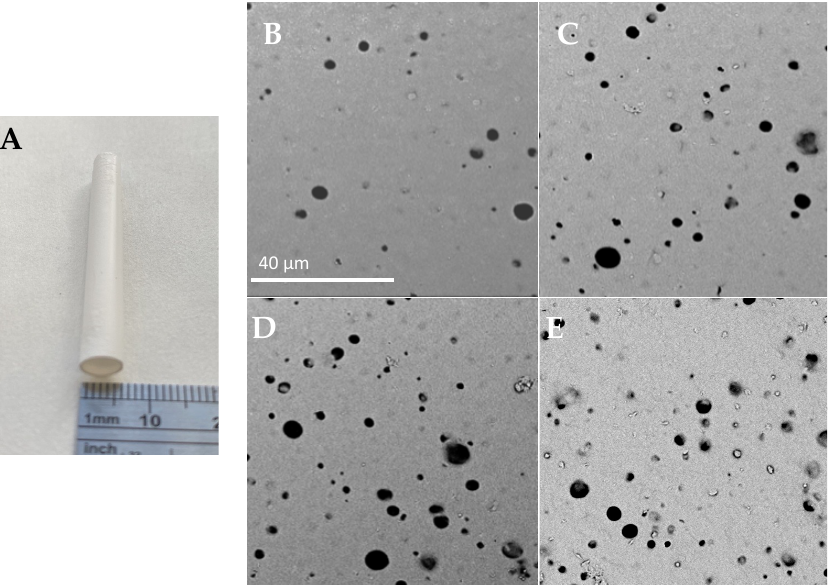
Figure 1. ( A ) Macroscopic images of prosthesis’; Morphology of prosthesis’ internal surface, ( B ): PU, ( C ): PU_AA, ( D ): PU_REDV, ( E ): PU_YIGSR; scale bar: 40 μm. The modification process extended the range of surface pore sizes (Figure 2). The average surface pores size has significantly increased ( p < 0.05) (Table 1)—from 3.0 ± 1.0 μm for unmodified PU to 4.4 ± 1.5 and 4.6 ± 1.9 for PU_REDV and PU_YIGSR. Similarly, an increase in maximum (from 5.8 μm for PU to 9.5/10.1 μm for PU_REDV/PU_YIGSR) and minimal (from 1 μm for PU to 1.4/1.6 μm for PU_REDV/PU_YIGSR) size was ob- served.